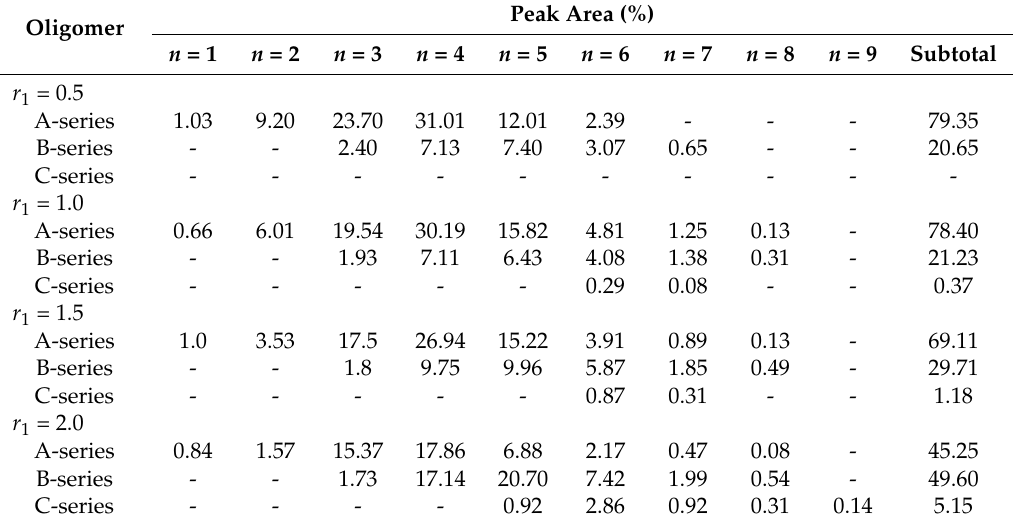
Table 3. Integrated peak areas of phenylsiloxanols prepared at various molar ratios of water to silane agent ( r 1 ), where n is the number of silane monomers in oligomers. Reprinted with permission from [56]. Copyright Elsevier,